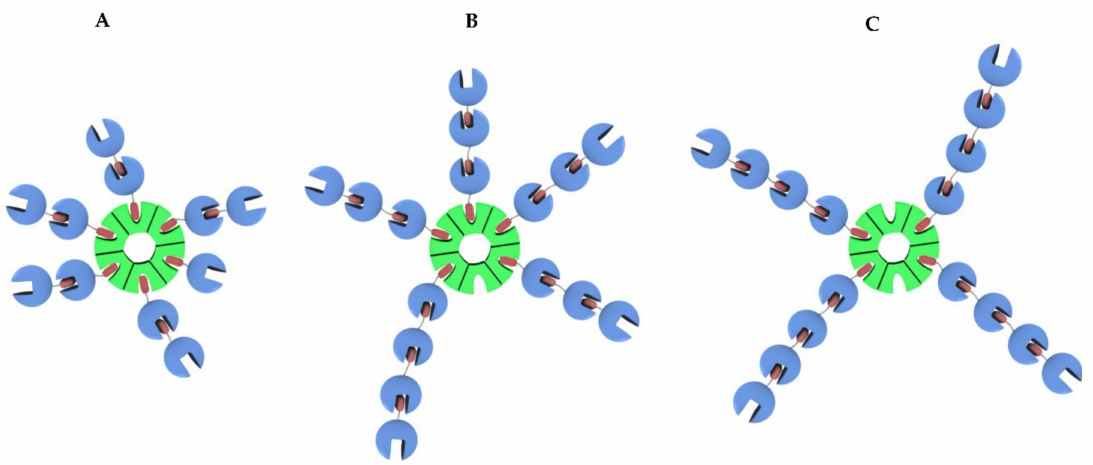
Figure 8. Schematic representation of one of the examples of structures for 1/1-( 1 -Cyt b 562N80C ) n -apoHTHP assembly ( A ) and two examples of the structures for 3/1-( 1 -Cyt b 562N80C ) n -apoHTHP assembly ( B , C